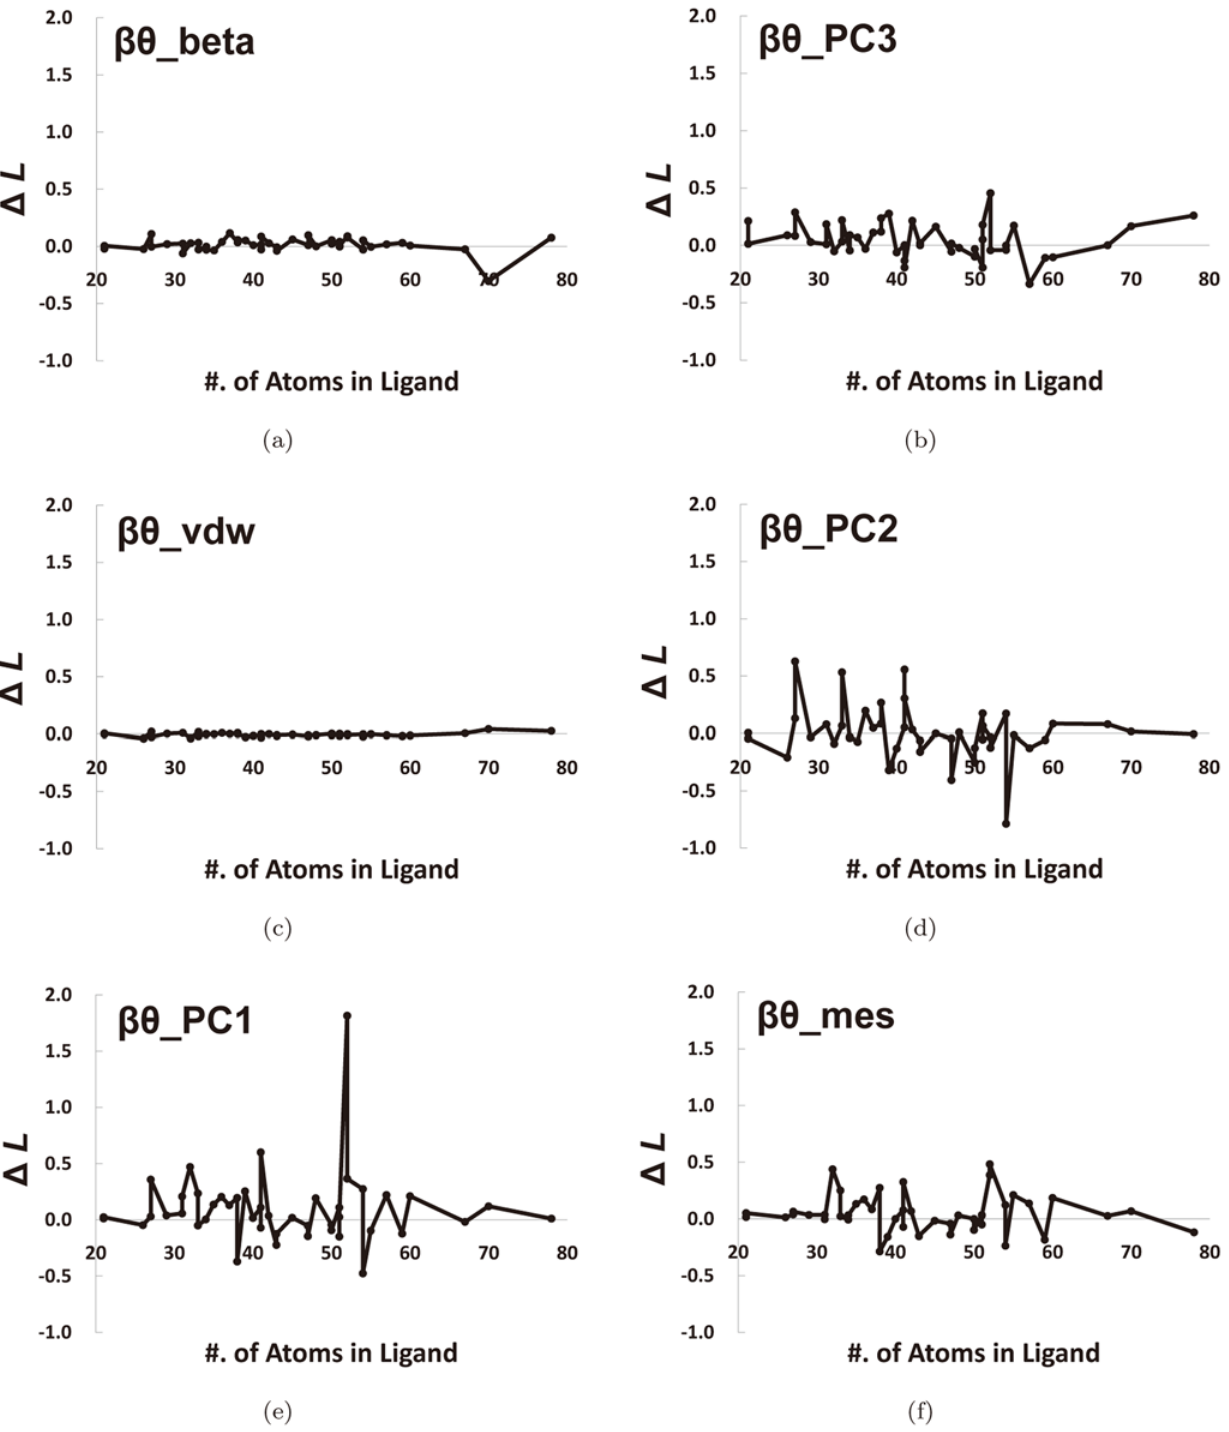
Fig 15. Difference in the β θ values by change of the ligand conformation. D L ¼ b bound minimum